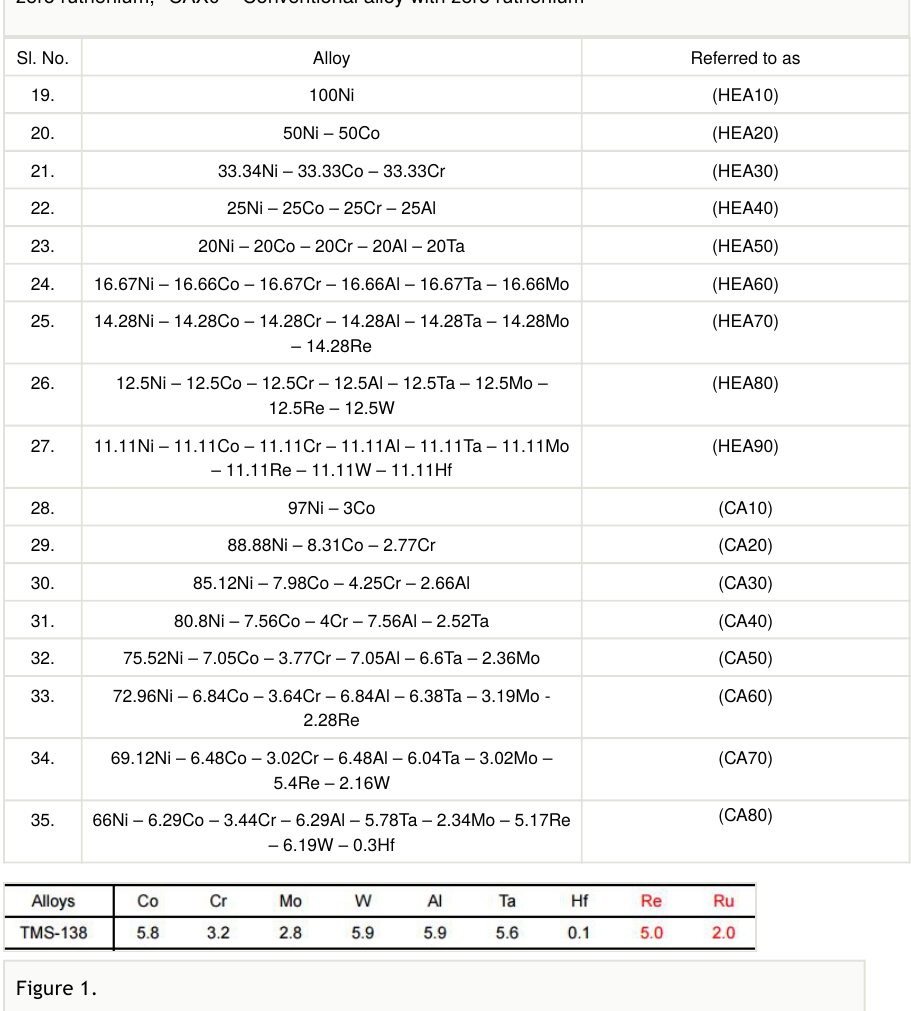
Figure 1. Chemical composition of TMS 138